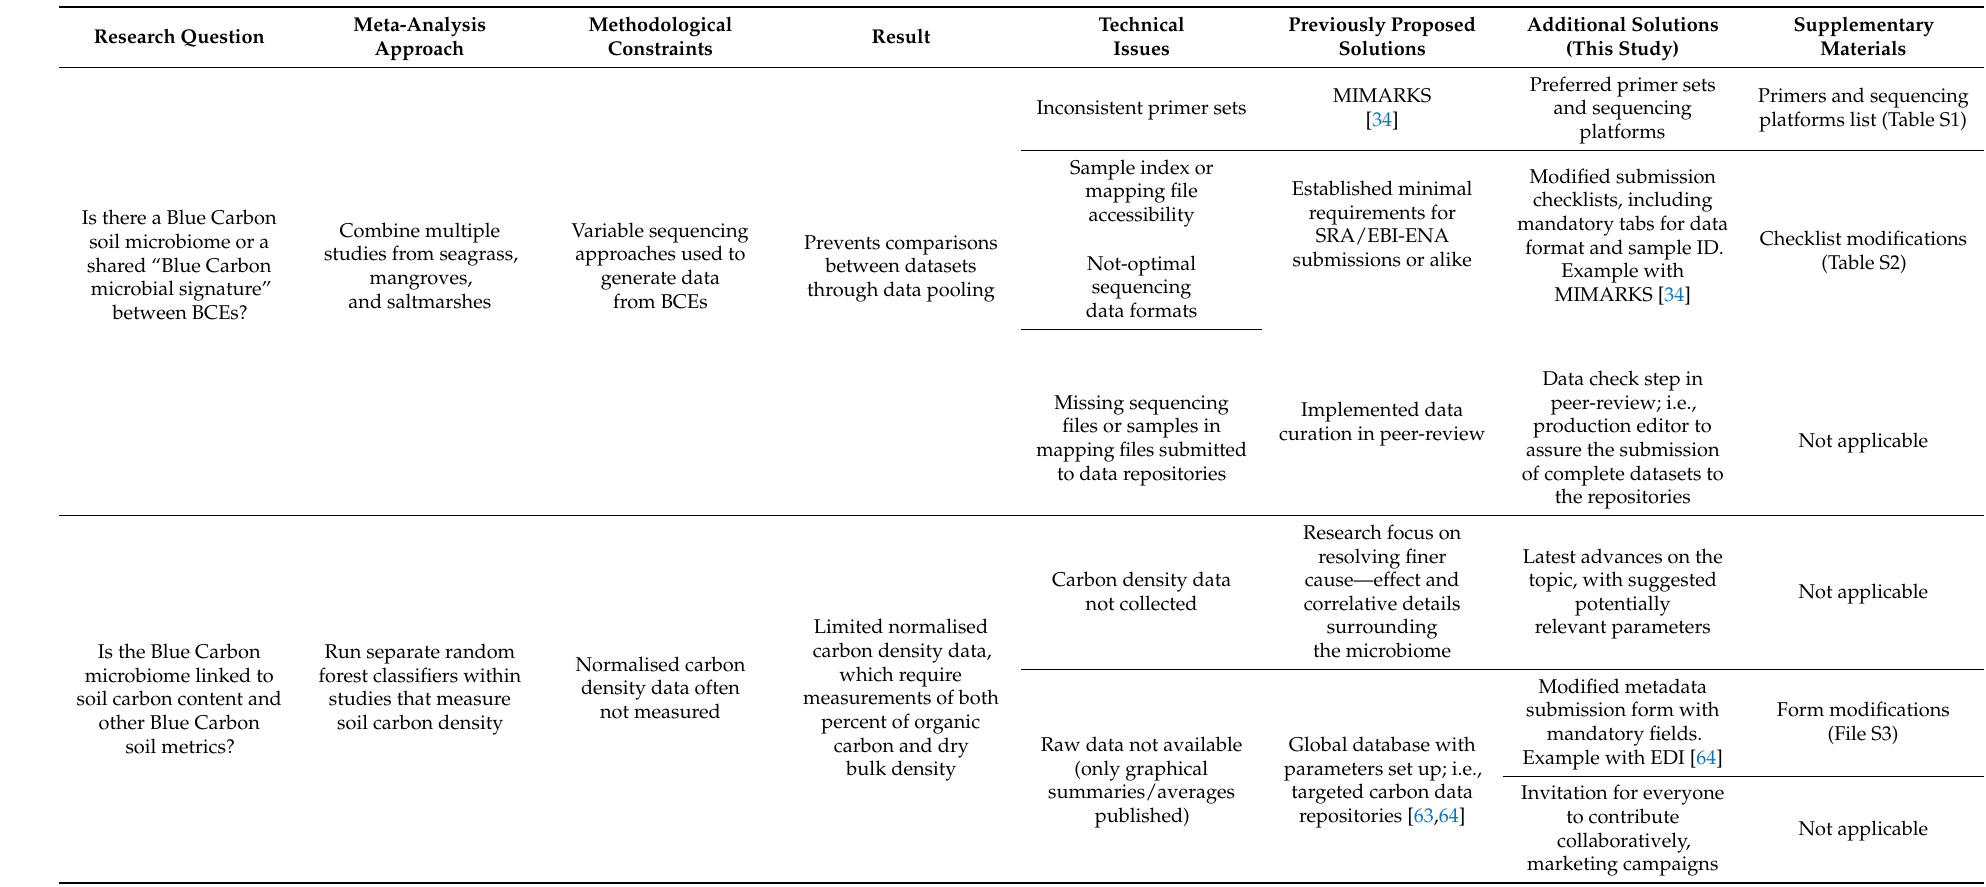
Table 1. Barriers to meta-analyses on currently available data and proposed solutions. Challenges revealed by attempted exploration of the Blue Carbon belowground or soil microbiome through meta-analysis on existing data, previously proposed solutions, and new suggested